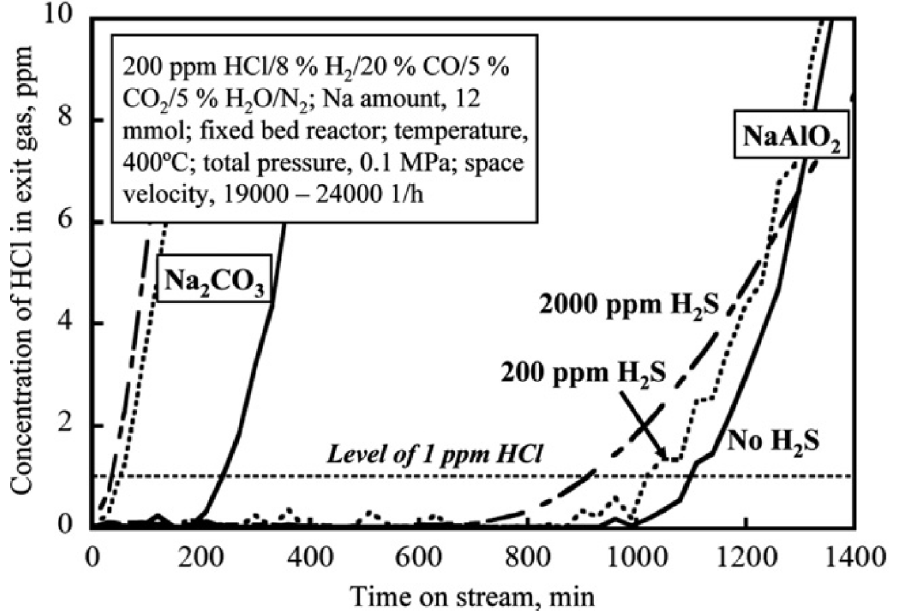
Figure 7. Breakthrough profiles for HCl sorption with Na 2 CO 3 and NaAlO 2 at 400 °C in a simulated fuel gas, without and with H 2 S added